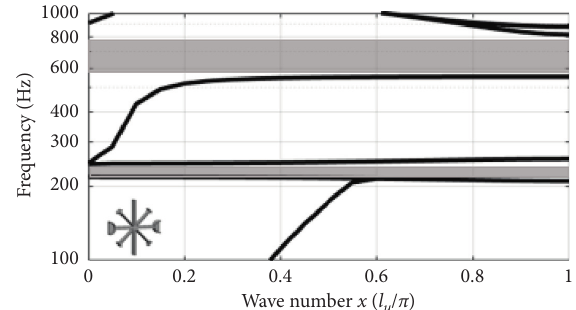
Figure 7: Dispersion curve and frequency bandgaps of a meta- material structure consisting of cantilever beams with tip coils and central magnet obtained using COMSOL simulations. Frequency bandgaps: the first and second bandgaps are 218–247Hz and 589–780Hz, respectively (marked in